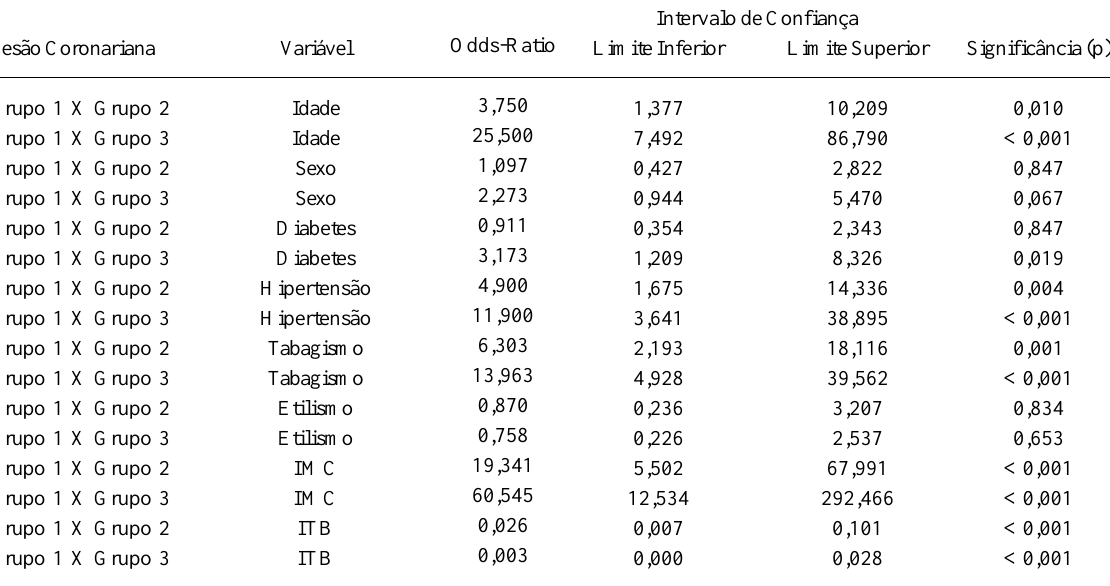
Grupo 1: ausência de lesão coronariana; Grupo 2: doença obstrutiva leve a moderada (estenose < 70%); Grupo 3: doença obstrutiva grave (lesão > 70%). ITB - Índice Tornozelo-braço.IMC - Índice de Massa